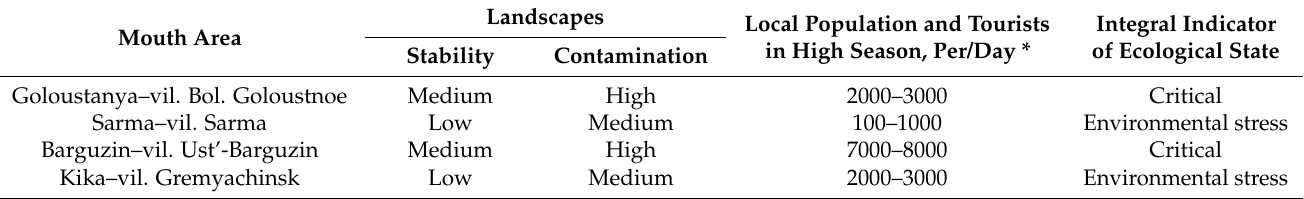
Table 4. Ecological state of the mouth areas of the tributaries of Lake Baikal